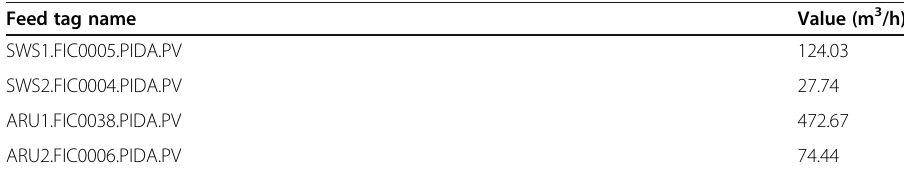
Table 4 SWS tag names in the PHD system Feed tag